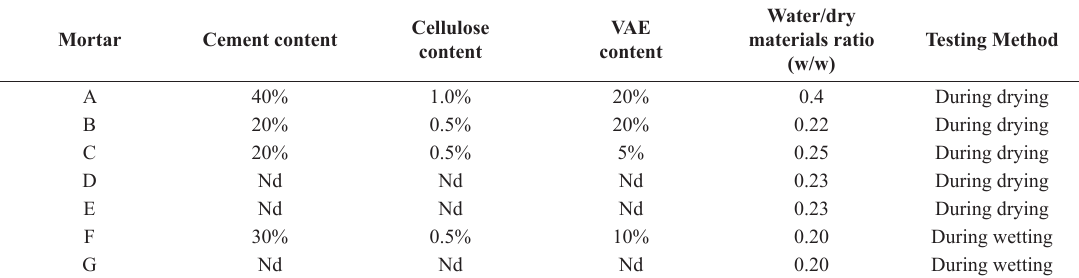
Figure 1. Experimental sequence for the drying test, schematically explaining the moisture content variation over time and the ages of the pull-out tests. Table 1. Mortar formulations. All values refer to total dry